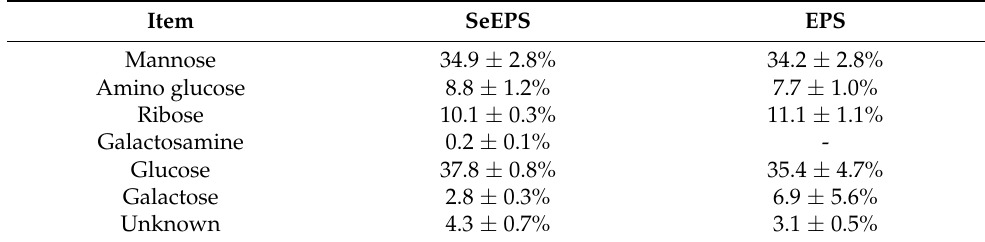
Table 2. Monosaccharide composition of SeEPS and EPS.